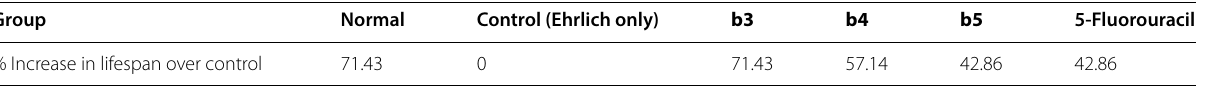
Table 17 In vitro anticancer activity results of active compounds Group